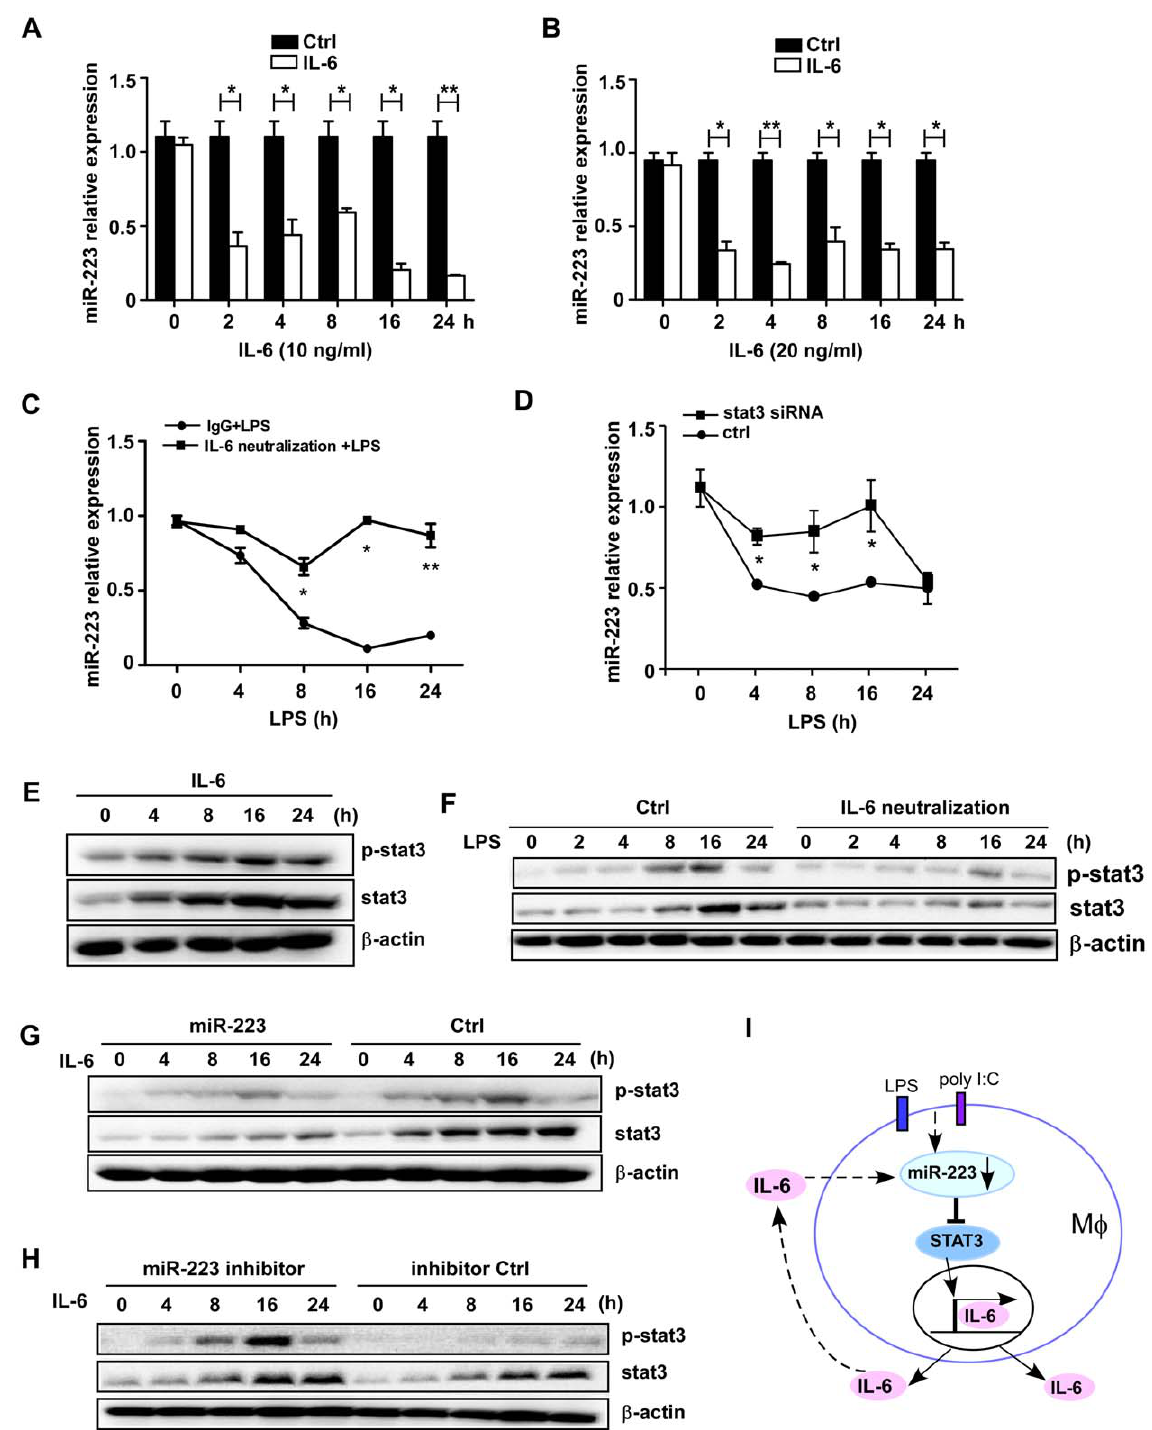
Figure 8. IL-6 acts as a main factor responsible for the down-regulation of miR-223 expression. (A–B) RAW264.7cells werestimulatedwith 10 or20 ng/ml ofrecombinant IL-6 forthe indicated time points.The expression ofmiR-223 was determined byqPCR and normalized tothe expression of U6. (C) Cells were treated with a mouse IL-6-specific blocking antibody or isotype control antibody (IgG1) upon LPS challenge. MiR-223 expression was determined by qPCR at the indicated time points.* p , 0.05, ** p , 0.01. (D) RAW264.7 cells were transfected with STAT3 siRNAat the final concentration of 30 nM. The expression of miR-223 was analyzed by q-PCR after LPS treatment for the indicated time. * p , 0.05. (E) Cells were treated with mouse IL-6 (5 ng/ml) for the indicated time pointsand levels oftotal andphosphorylatedSTAT3 wereanalyzedbyimmunoblotting. (F) Cellswerepretreated withIL-6 neutralization or IgG1 control antibody, STAT3 protein and phosphorylation levels were determined by immunoblotting at the indicated time points after LPS (100 ng/ml) stimulation. (G, H) RAW264.7 cells were firstly transfected with miR-223 mimics or inhibitors and their controls. After 24 h, cells were treated with IL-6 and levels of total and phosphorylated STAT3 were analyzed by immunoblotting. Data are representative of three independent experiments. (I) The proposed positive regulatory loop of IL-6/miR-223/STAT3 pathway in regulating the TLR-triggered inflammatory response. doi:10.1371/journal.pone.0042971.g008 PLOS ONE |